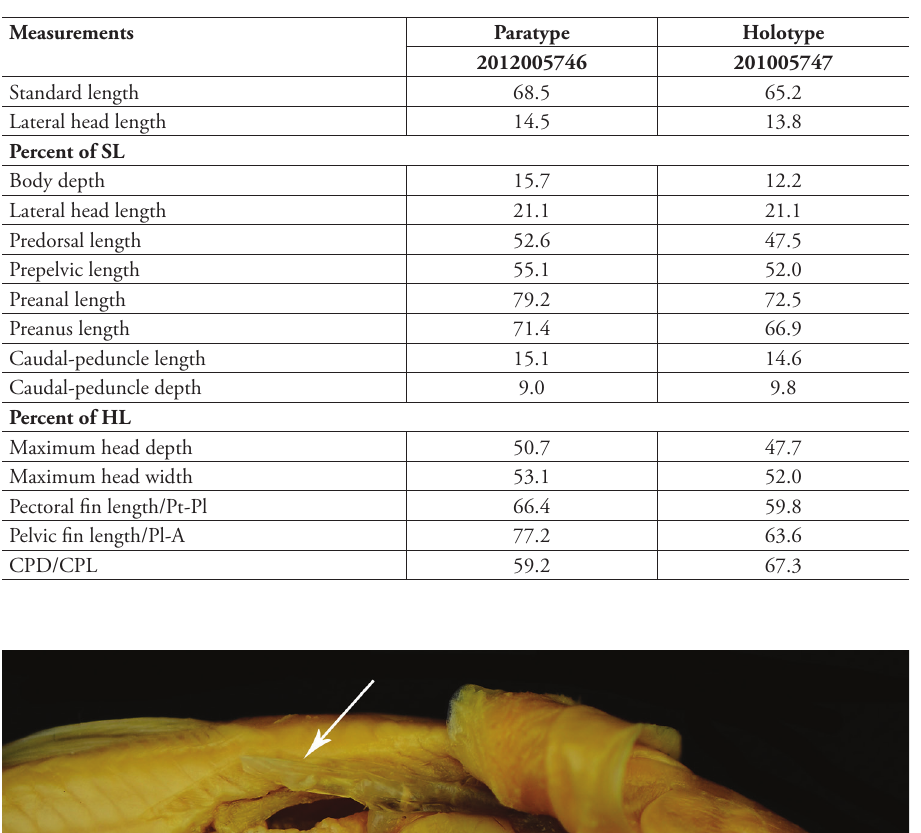
Table 1. Morphometric data of type specimens of Triplophysa anshuiensis sp. n.